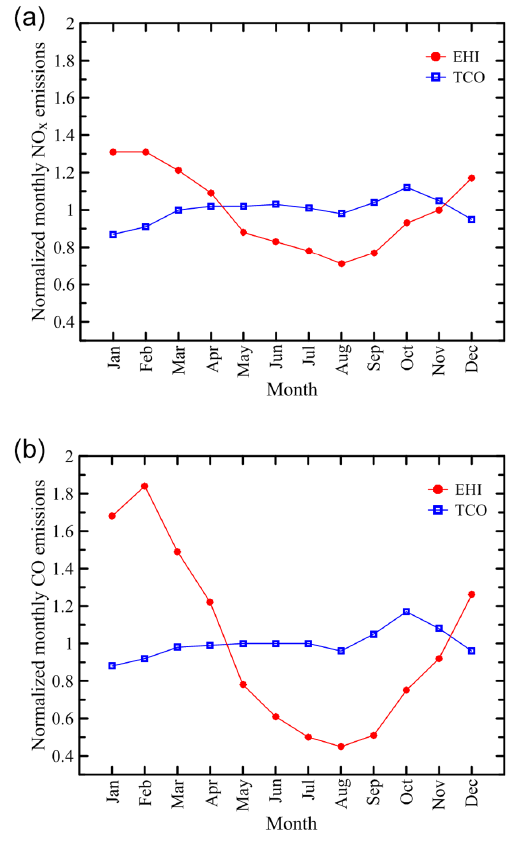
Figure 2. The seasonal variations of the spatially averaged (over the study region) NO x (a) and CO (b) emissions for the EHI and TCO categories of sources. The variations were calculated as explained in Sect. 2.3. The values shown (unitless) are the monthly emissions normalized to the total annual emissions divided by